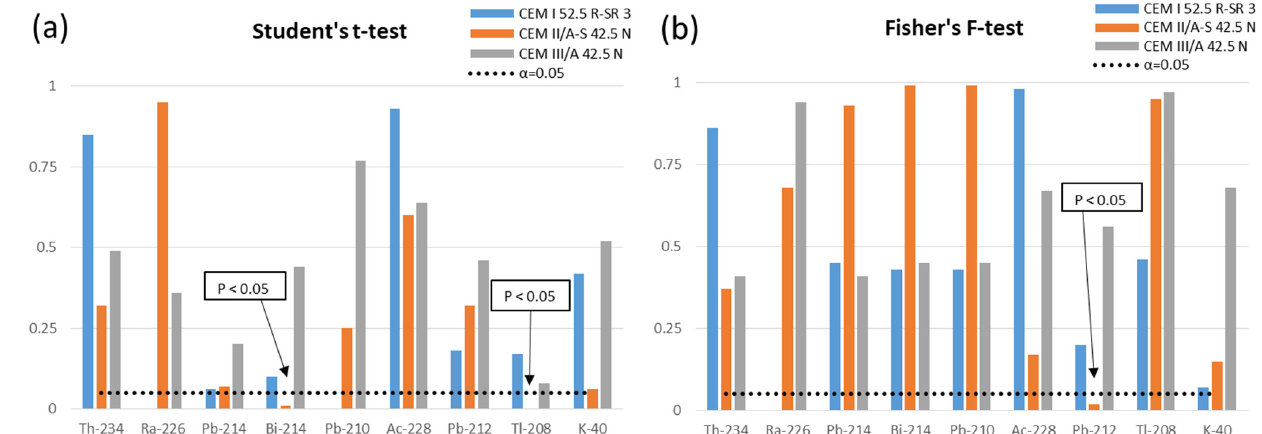
Figure 1. ( a , b ) Results of the evaluation of the mean (Student’s t -test) and variance (Fisher’s F-test) between the solid and ground mortars.